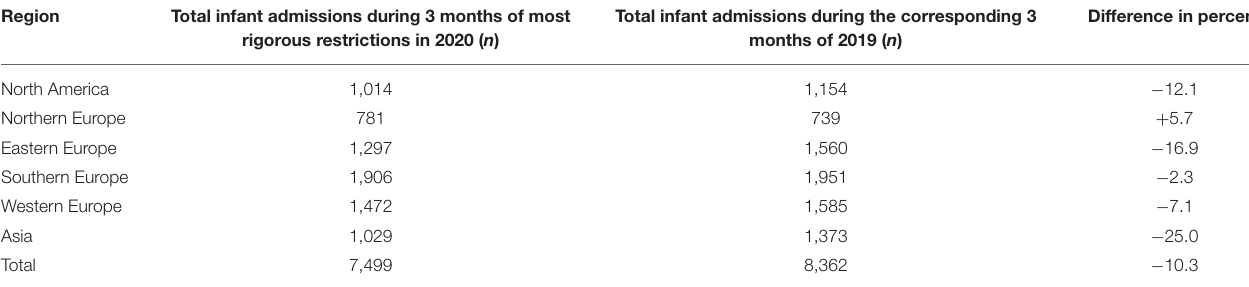
TABLE 5 | Total NICU admissions in 2020 and 2019 within each pre-defined geographic region.